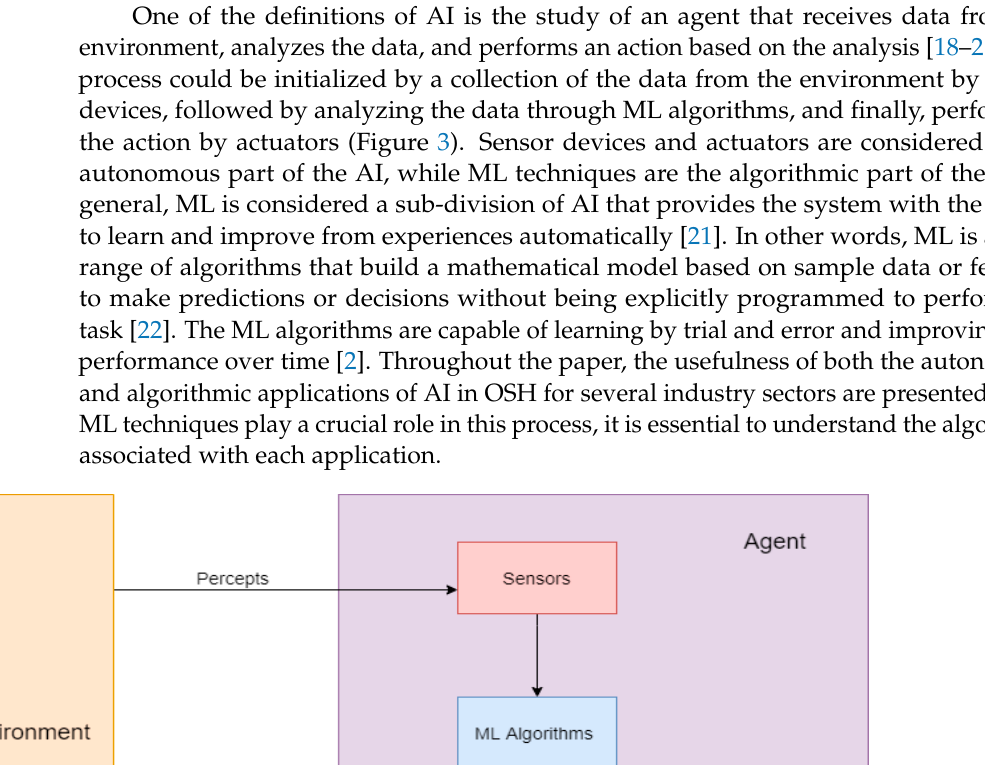
Figure 2. The number of publications demonstrating the use of AI in the OSH field from 1986 to 2019. The x-axis is the year of publication and the y-axis is the number of the AI papers published with an OSH application. All AI papers queried were individually reviewed to confirm the OSH application.